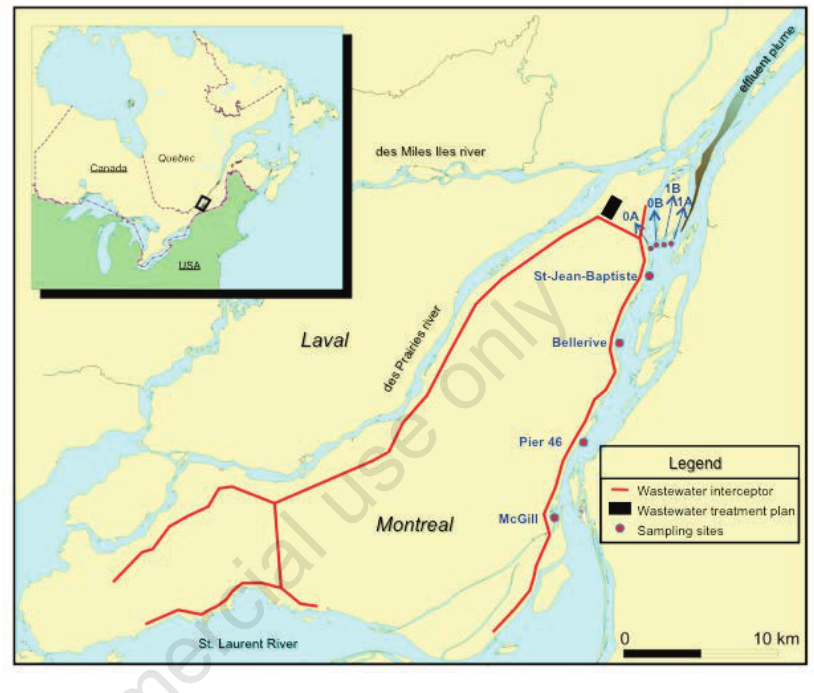
Figure 1. Sampling sites near discharge points in the St. Lawrence River and along a tran- sect further downstream Montreal Island